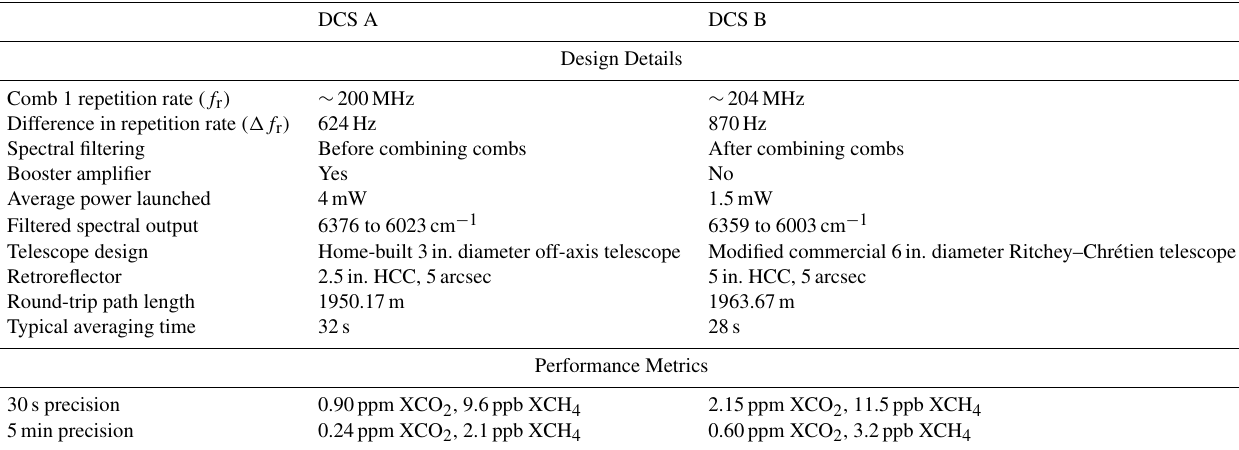
Figure 2. Setup for the open-path dual-comb spectrometer (DCS) comparison at the NIST Boulder, CO campus. The main components for DCS A and DCS B are housed in a rooftop laboratory, including the frequency combs, telescope, receiver, and processor. For each DCS, the combined comb light is launched from a telescope; travels ∼ 1km through the atmosphere to a retroreflector; and returns to the telescope, where it is collected, detected, and processed. A separate cavity ring-down point sensor (CRDS) is located nearby with an inlet on a 30m tower that is located ∼ 160m from the nearest point of the free-space DCS paths. Table 1. Specifications of the two DCS systems. HCC: hollow corner